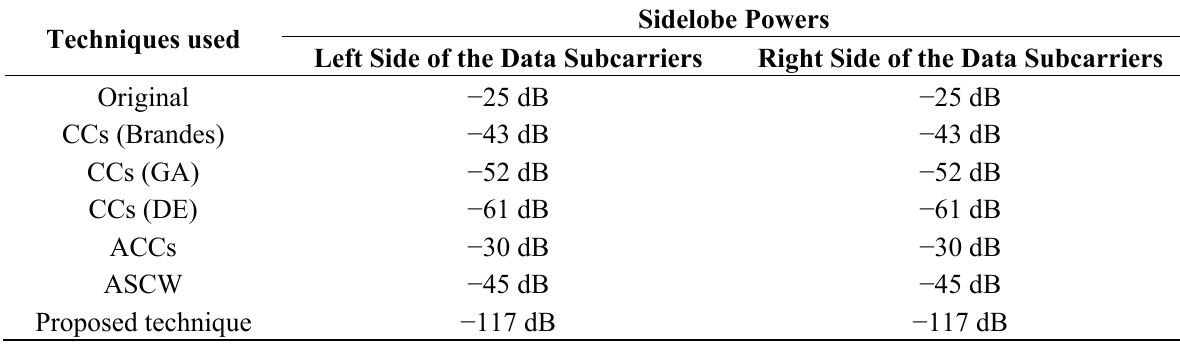
Table 1. Comparison of sidelobe suppression between existing and proposed techniques. Techniques